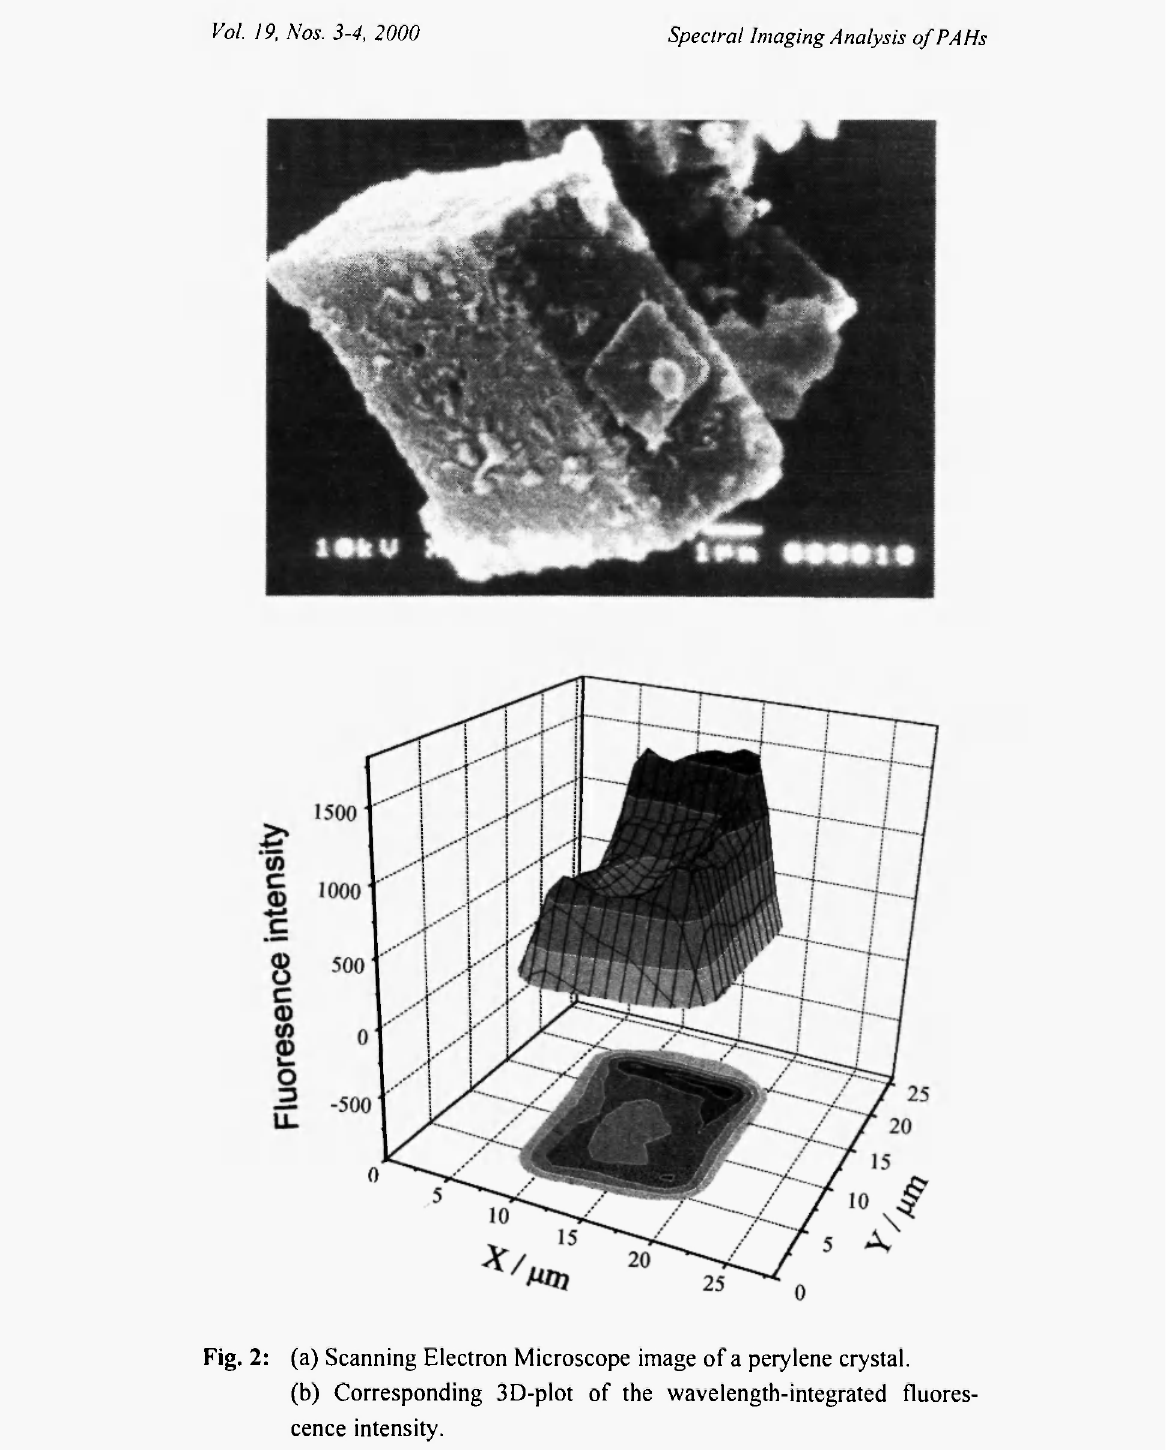
Fig. 2: (a) Scanning Electron Microscope image of a perylene crystal. (b) Corresponding 3D-plot of the wavelength-integrated fluores- cence